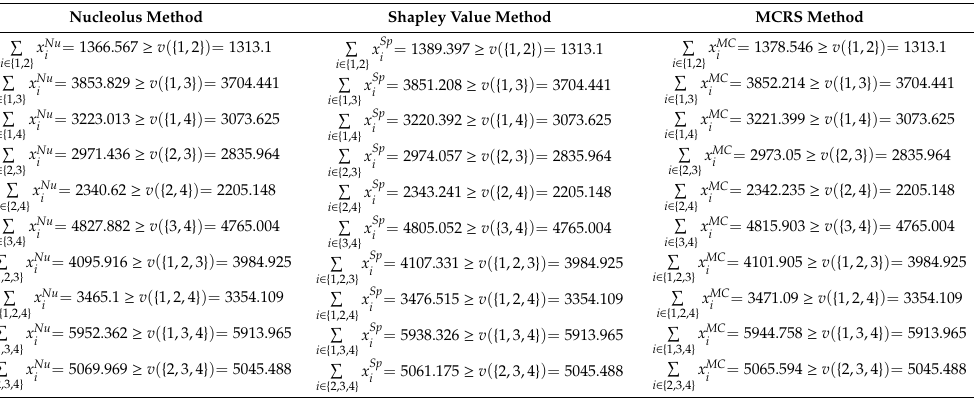
Table 4. Coalitional rationality analysis (MWh).